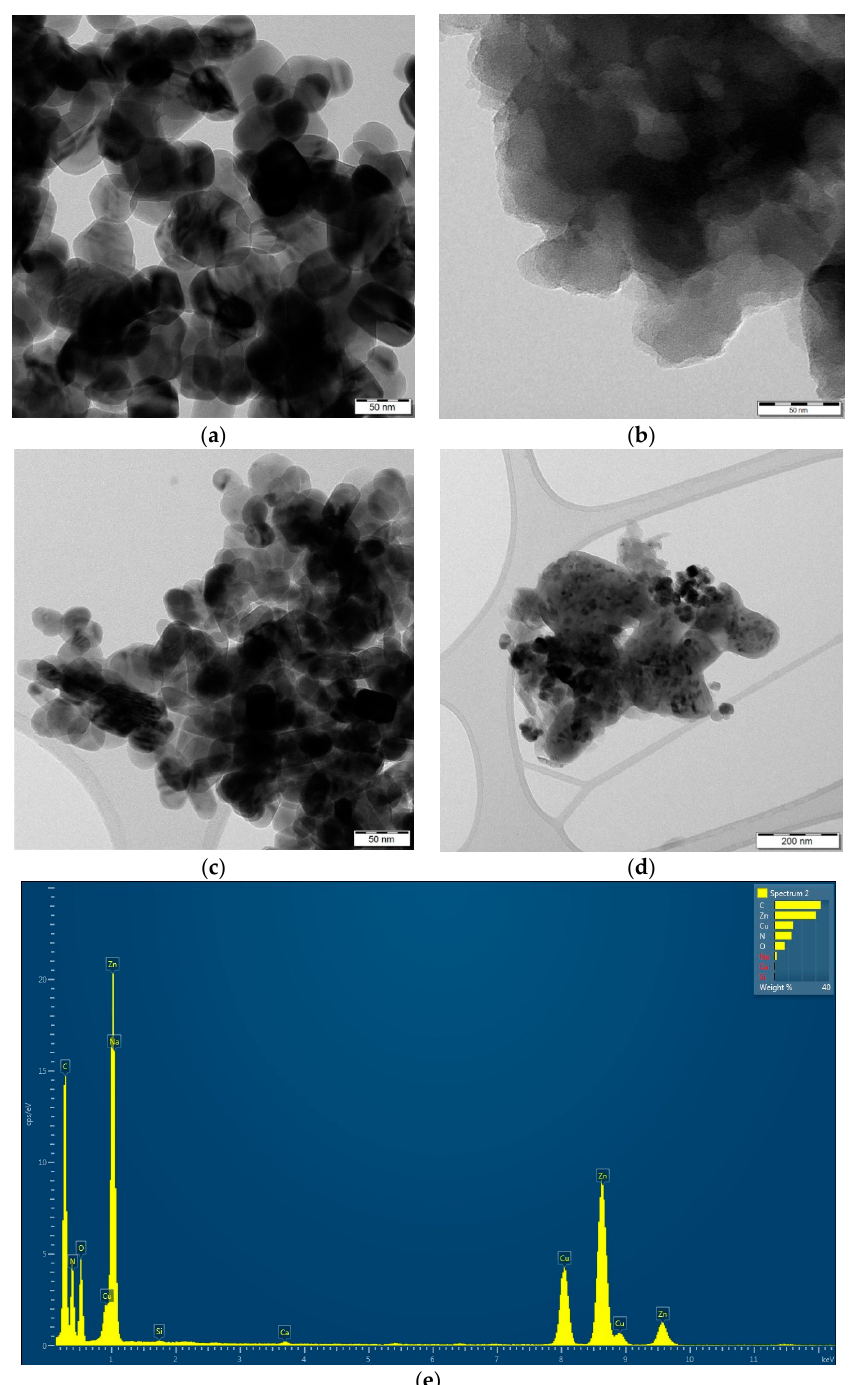
Figure 6. TEM images of ZnO ( a ), g-C 3 N 4 ( b ), and g-C 3 N 4 /ZnO (3:1) ( c , d ) and EDS analysis of g-C 3 N 4 /ZnO (3:1) ( e ).